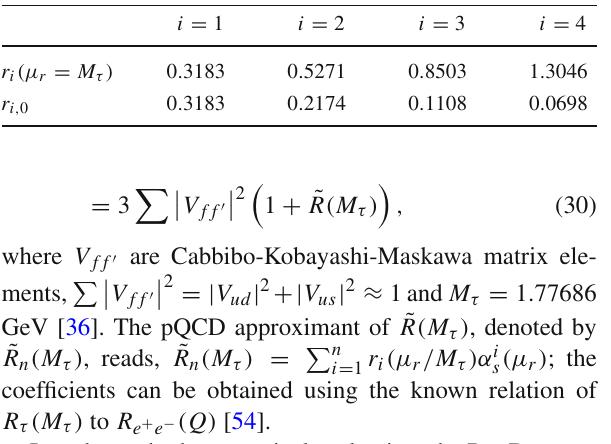
Table 2 The known coefficients for ˜ R n ( M τ ) . The coefficients of con- ventional scale setting, r i (μ r ) , are for μ r = M τ . The conformal coef- ficients, r i , 0 , are scale-independent